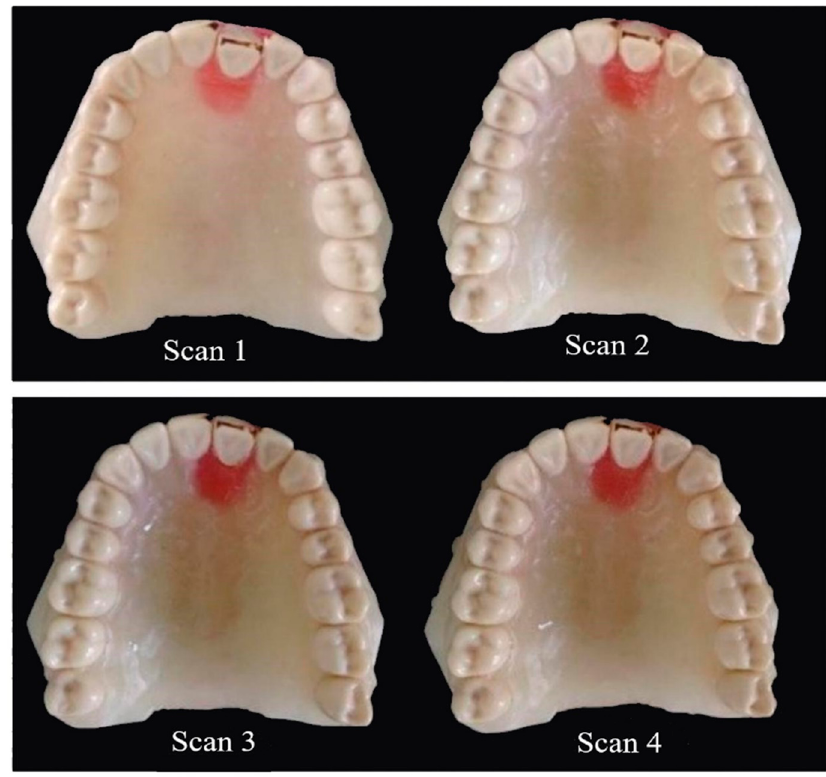
Figure 5. Model T before scanning at the different stages of treatment.